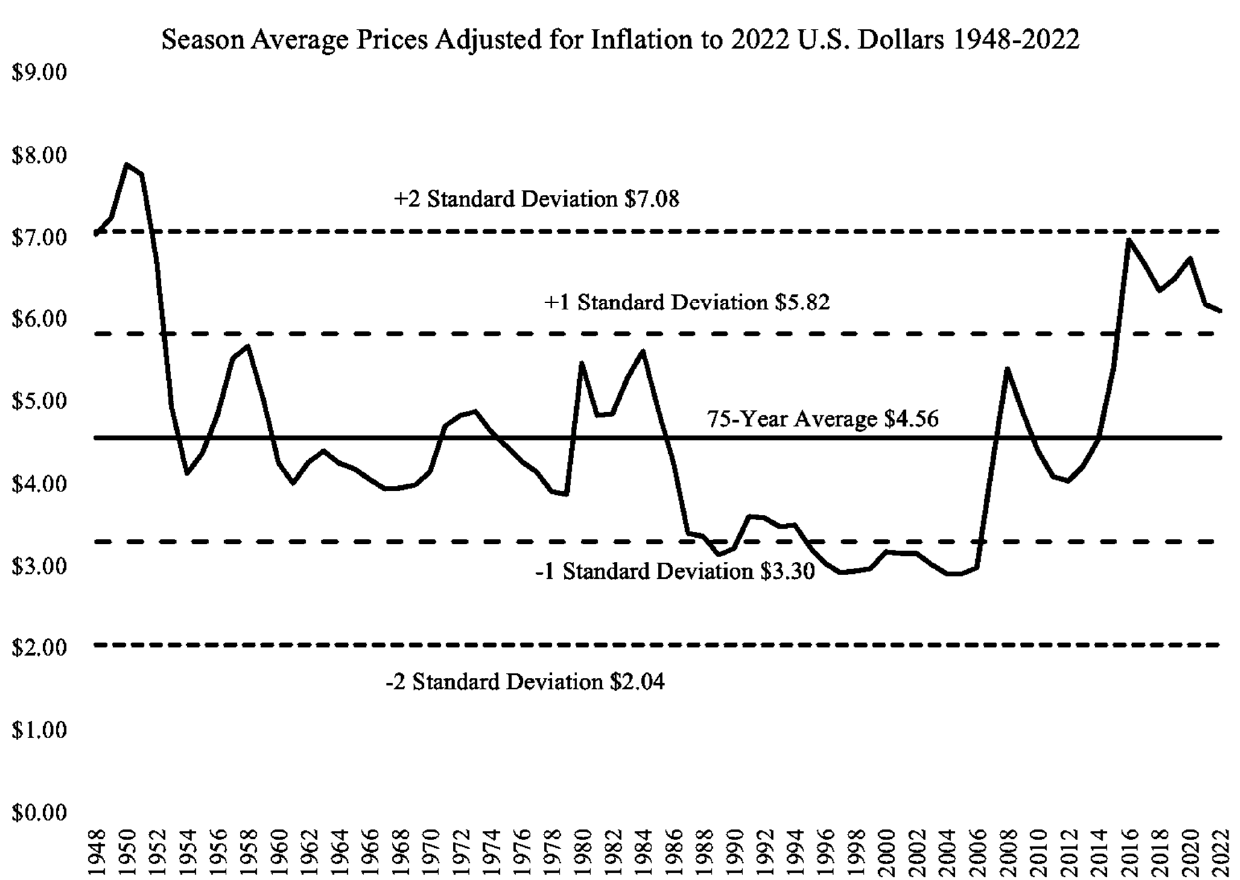
Figure 4. U.S. Season Average Prices 1948–2022 Adjusted for Inflation Using CPI (own study based on [16,23,24]).